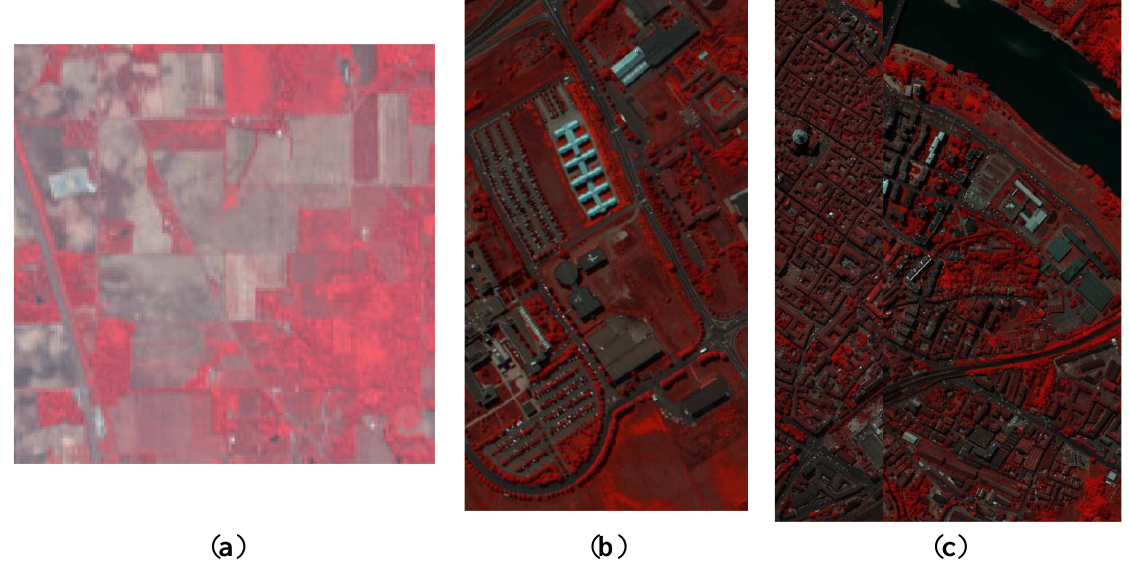
Figure 1. False color of IR images for datasets ( a ) Indian Pines Site (IPS); ( b ) Pavia University; and ( c ) Pavia City